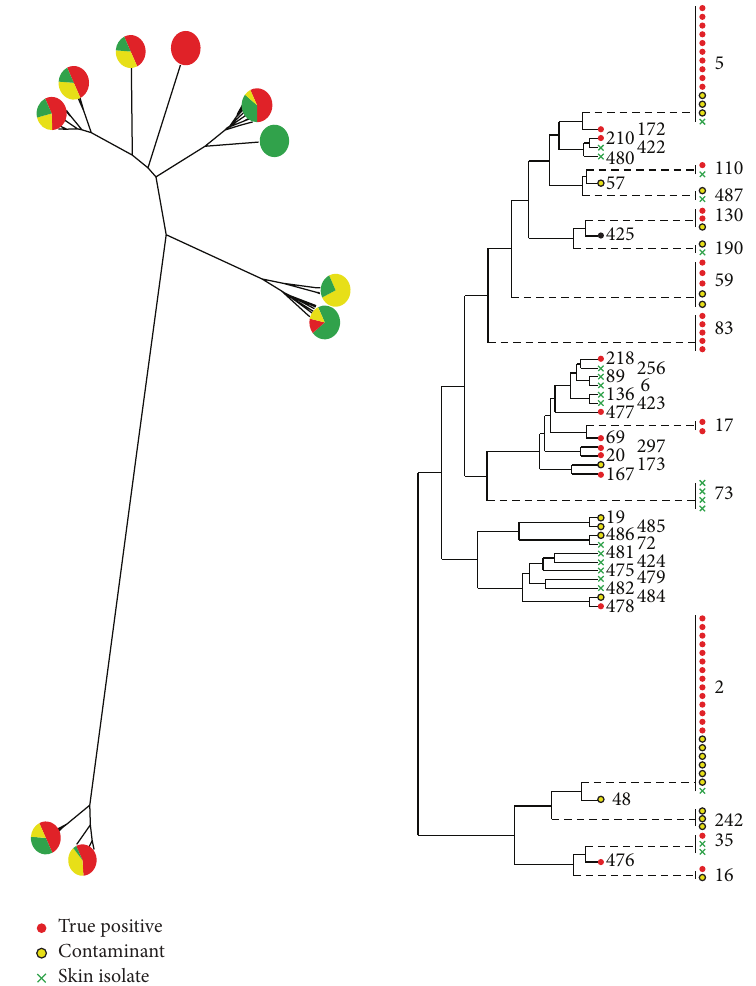
Figure 1: Staphylococcus epidermidis dendrogram of relatedness of 50 true positive isolates (red), 25 likely contaminant isolates (yellow) and 25 isolates from the skin of healthy volunteers (green) using multilocus sequence typing. At left, associated pair charts show distribution of isolate source in various arms. At right, numerical values represent the sequence type derived from sequencing of 7 genes of S. epidermidis . While in general the horizontal distance between strains depicts their genetic dissimilarity, dashed lines reflect sequence types that have been horizontallyshiftedtotherighttopreservereadabilityofthefigure.MLSTrevealedsignificantvariabilityinsequencetypeinthisprospectively gathered sample and large overlap in sequence type among strains of different